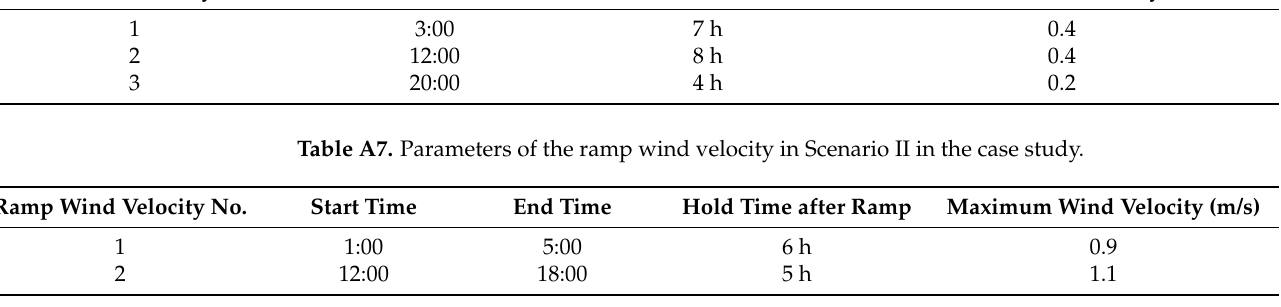
Table A6. Parameters of the gust wind velocity in Scenario II in the case study. Gust Wind Velocity No.